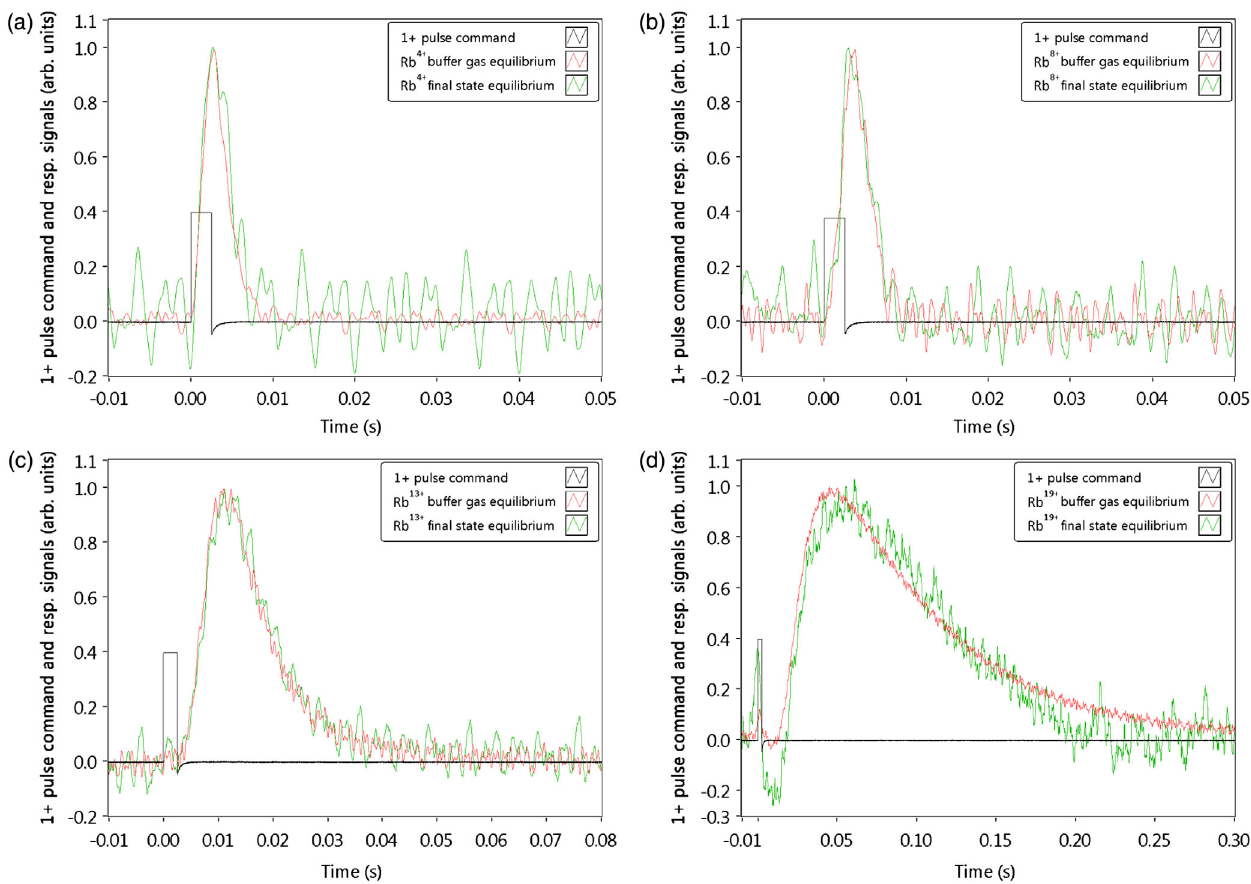
FIG. 11. Comparison of Rb 4 þ (a), Rb 8 þ (b), Rb 13 þ , (c) and Rb 19 þ (d) response signals in both plasma